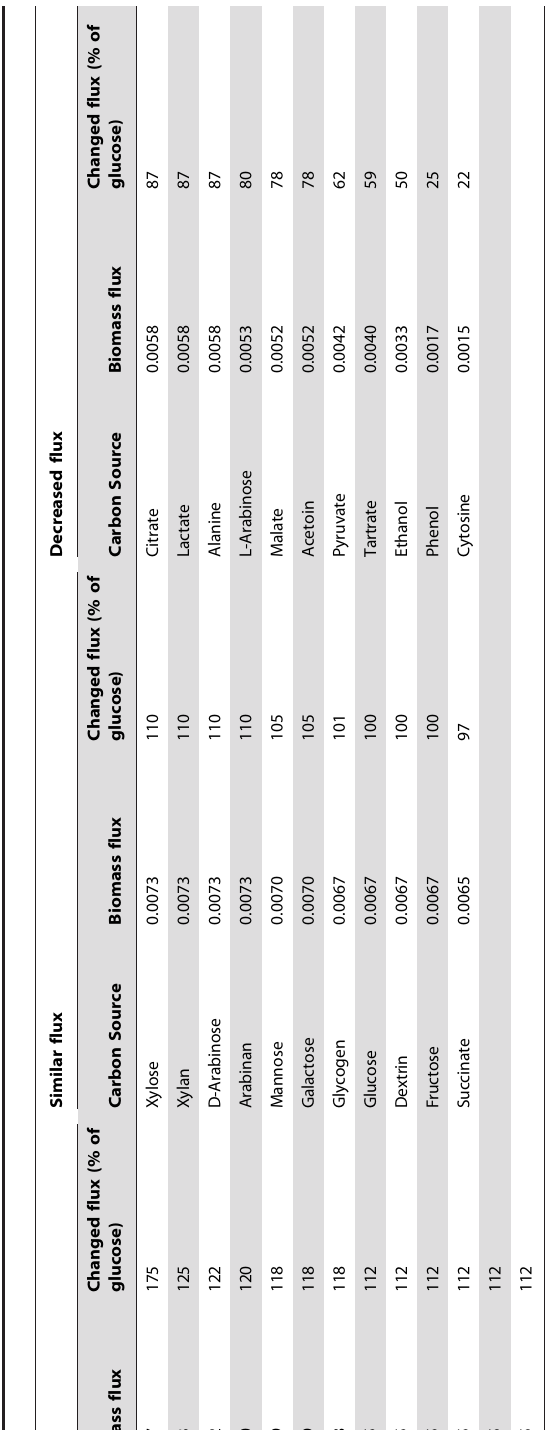
synthase (Figure 2: (11)), aconitase (NAD(P) + ) (two reactions; Figure 2: (12)), and fumarase (Figure 2: (17))). In the amino acid and lipid metabolism, 37% and 26% of the knockouts were lethal,